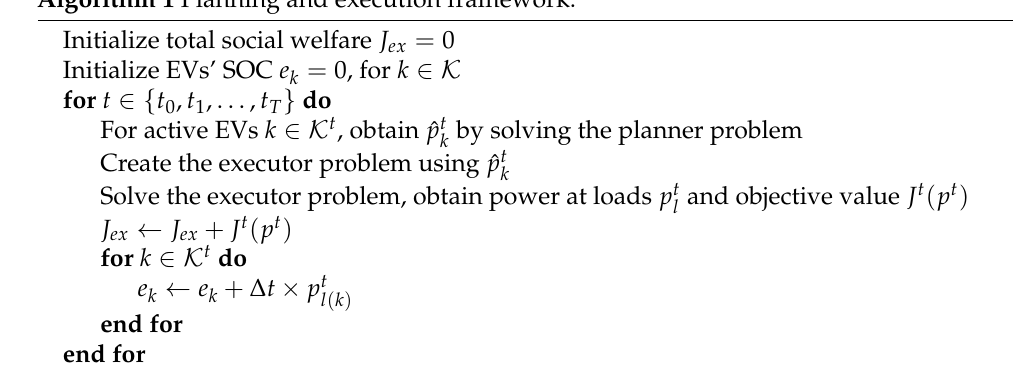
Algorithm 1 Planning and execution